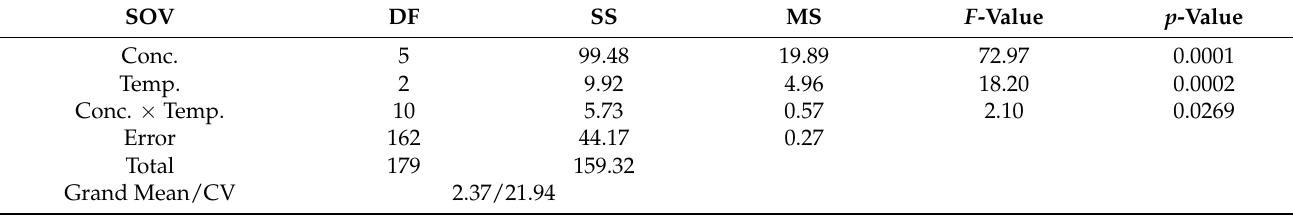
Table A4. Fecundity of M. persicae in relation to PeaT1 elicitor and temperature, (ANOVA). SOV DF SS MS F -Value p -Value Conc. 5 Temp. Conc. × Temp. Total